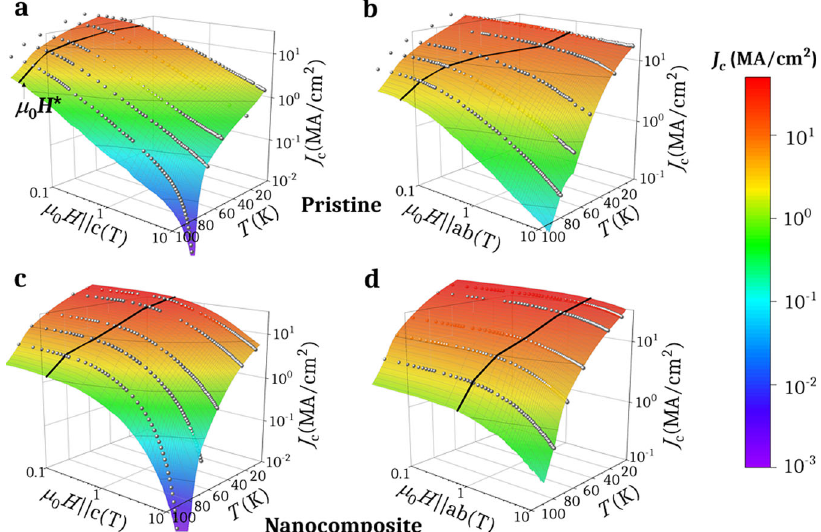
Fig. 1 J c ( H , T ) surfaces. J c ( H , T ) for ( a , b ) a pristine and ( c , d ) a nanocomposite for ( a , c ) H | | c and ( b , d ) H | | ab. Spherical symbols represent the measured J H ) curves and solid lines correspond to the accommodation magnetic fi eld μ c (